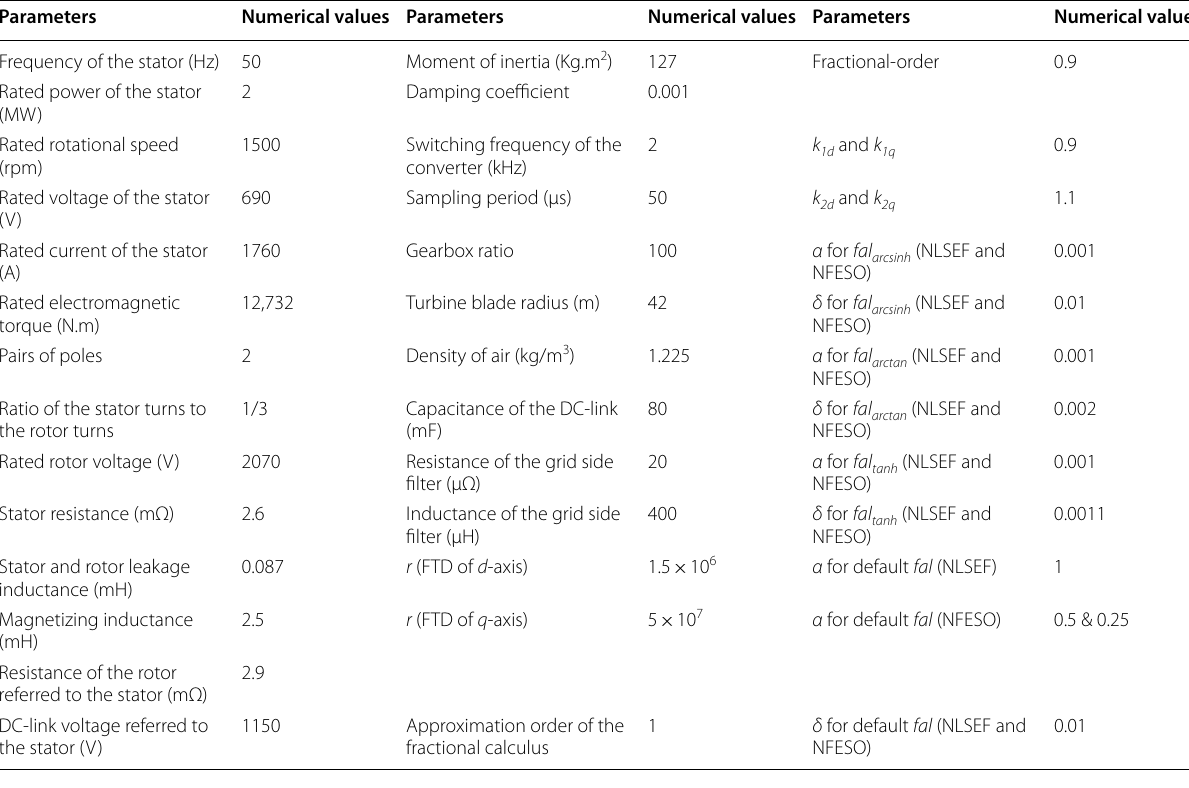
Table 3 Parameters of the simulated system